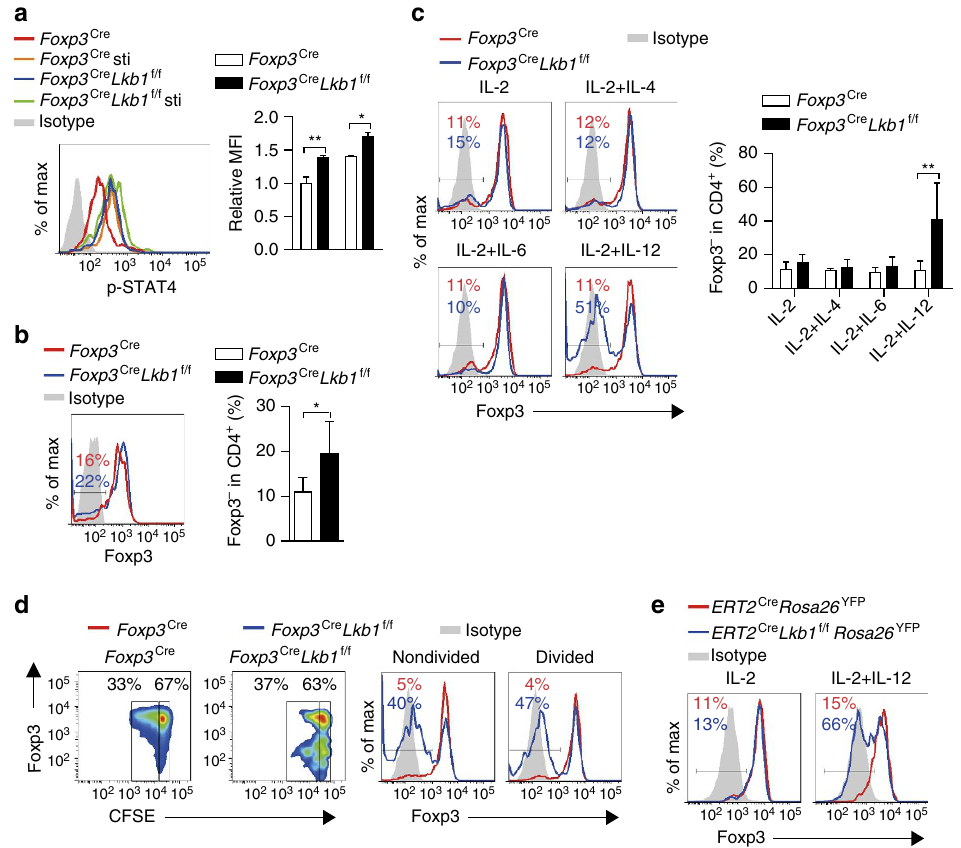
Figure 4 | Lkb1 prevents STAT4 activation to maintain T reg cell stability. ( a ) Intracellular phosphorylated STAT4 in Foxp3 Cre and Foxp3 Cre Lkb1 f/f T reg cells treated with or without IL-12 ( n ¼ 3). ( b ) Foxp3 expression in Foxp3 Cre and Foxp3 Cre Lkb1 f/f T reg cells co-cultured with DCs without any cytokines ( n ¼ 7). ( c ) Foxp3 expression in Foxp3 Cre and Foxp3 Cre Lkb1 f/f T reg cells co-cultured with DCs supplemented with indicated cytokines ( n ¼ 3). ( d ) Foxp3 expression in divided and nondivided Foxp3 Cre and Foxp3 Cre Lkb1 f/f T reg cells co-cultured with DCs for 4 days supplemented with IL-2 and IL-12. ( e ) Foxp3 expression in ERT2 Cre Rosa26 YFP and ERT2 Cre Lkb1 f/f Rosa26 YFP T reg cells co-cultured with DCs supplemented with indicated cytokines and 4-hydroxytamoxifen. Two-way analysis of variance (ANOVA) was used for statistical analyses in a , c , and unpaired two-tailed Student’s t -test was used for statistical analyses in b (* P o 0.05, ** P o 0.01); error bars represent s.d.; all data are representative of at least two independent